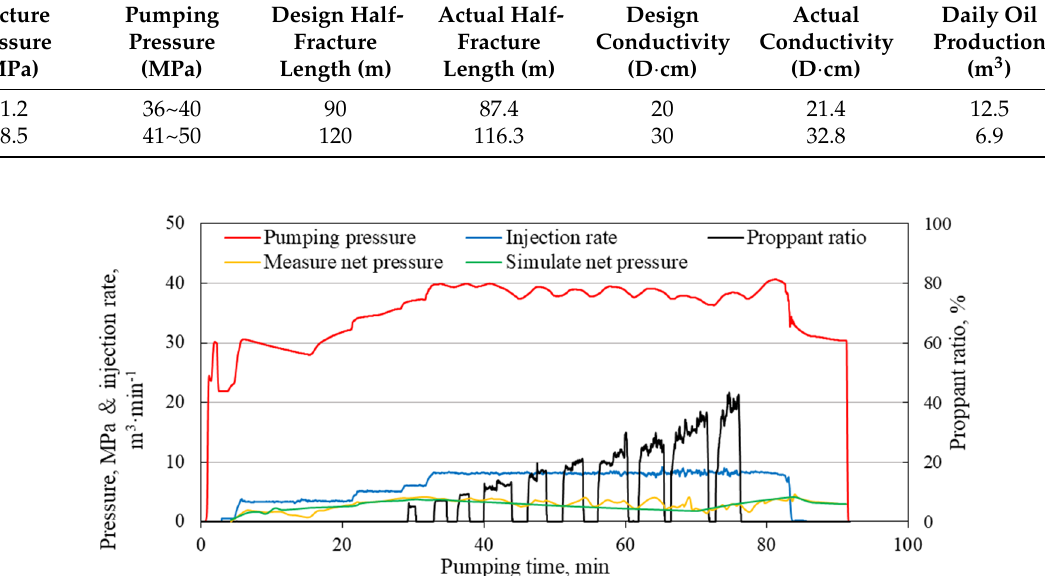
Figure 16. Construction data fitting curve. Table 5. Construction parameter comparison results.